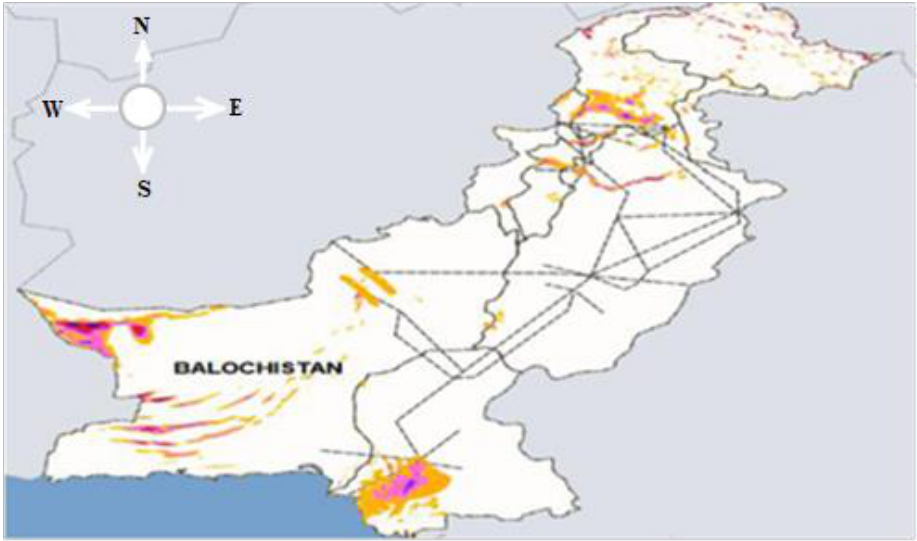
Figure 1. Transmission network in Pakistan (dotted lines indicate the existing networks).